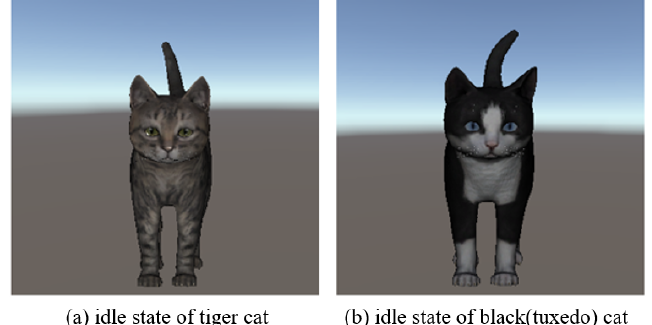
Figure 1. Animator configuration.